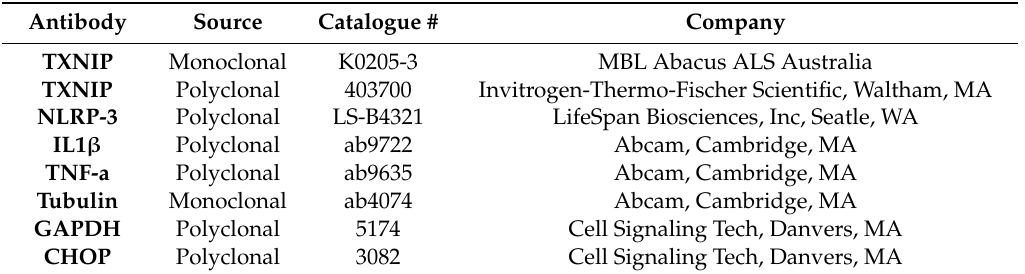
Table 2. List of antibodies and sources used to detect protein expression by Western Blot. Antibody